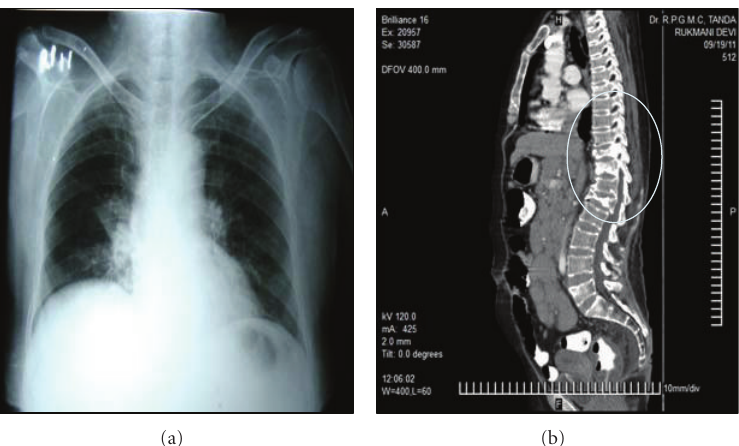
Figure 6: Segmental atelectasis in right parahilar region and bilateral hilar lymphadenopathy in X-ray chest (a). Vertebrae fractures of D10, D11, and L1 in CT scan ( encircled ) (b).